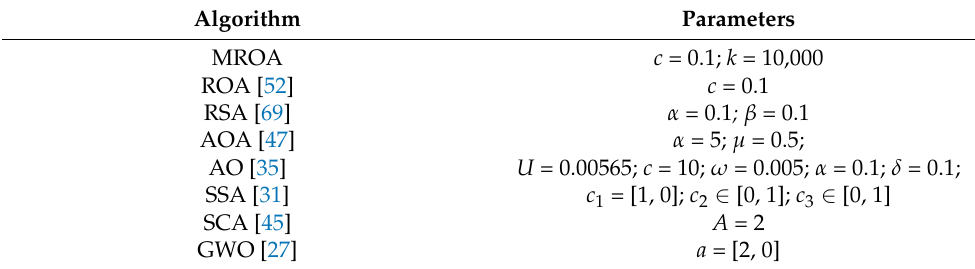
Table 2. Parameter settings for each